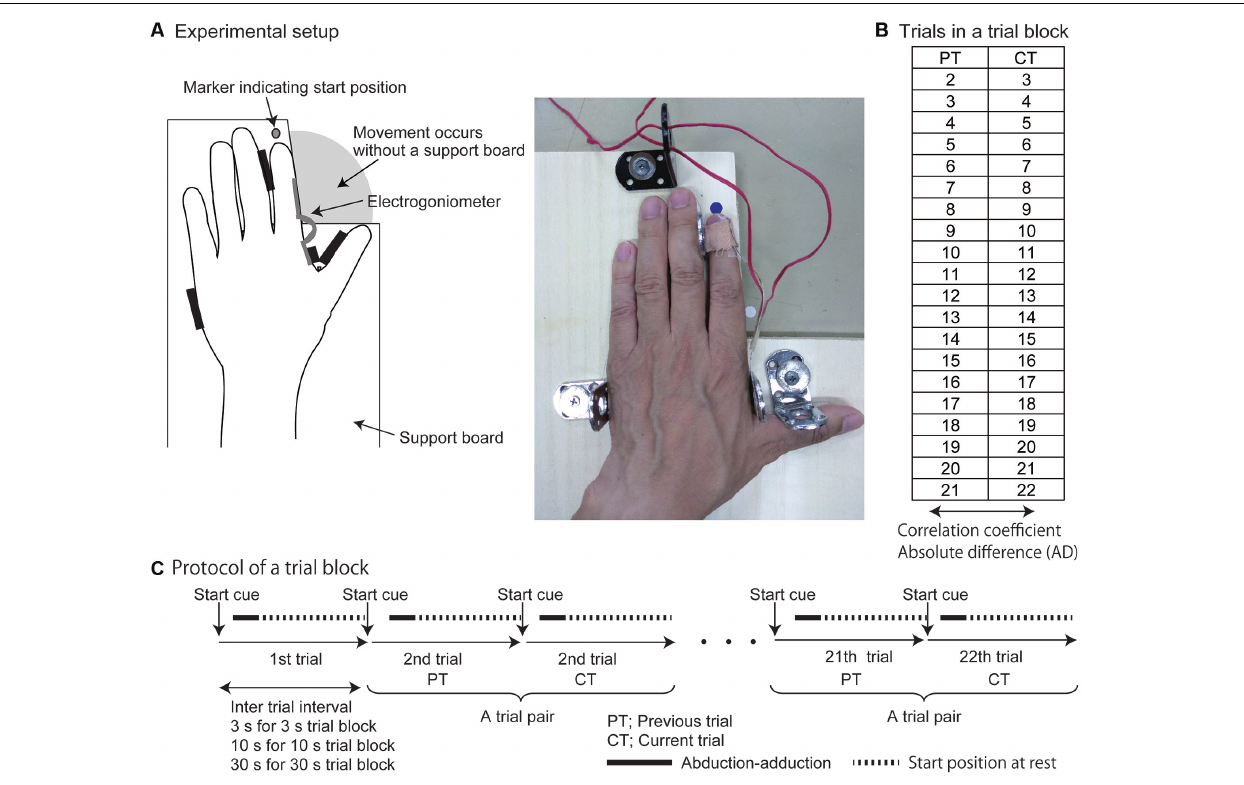
FIGURE 1 | Experimental setup (A) analyzed trials in a trial block (B) and protocol of a trial block (C) . Numbers in (B) indicate the order of the trials. The first trial was not analyzed as it had no trial preceding it, as described in the “Methods” section.